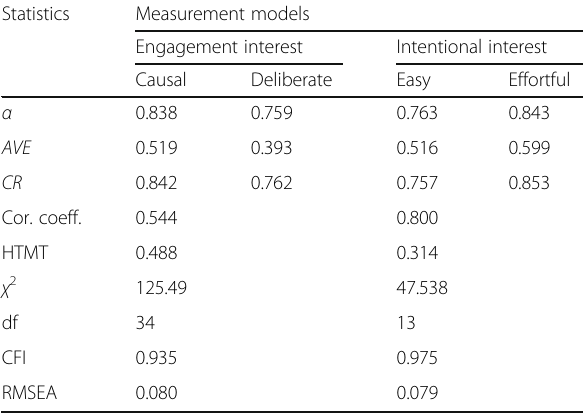
Table 5 Internal consistency, convergent validity,